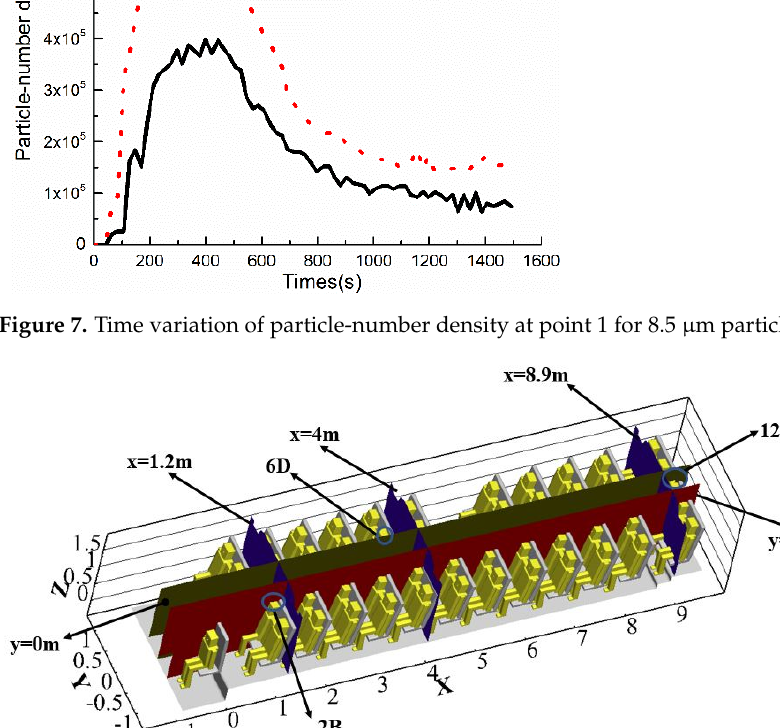
Figure 8. Selected planes of x = 1.2 m, 4 m and 8.9 m, y= − 0.46 m and 0 m.